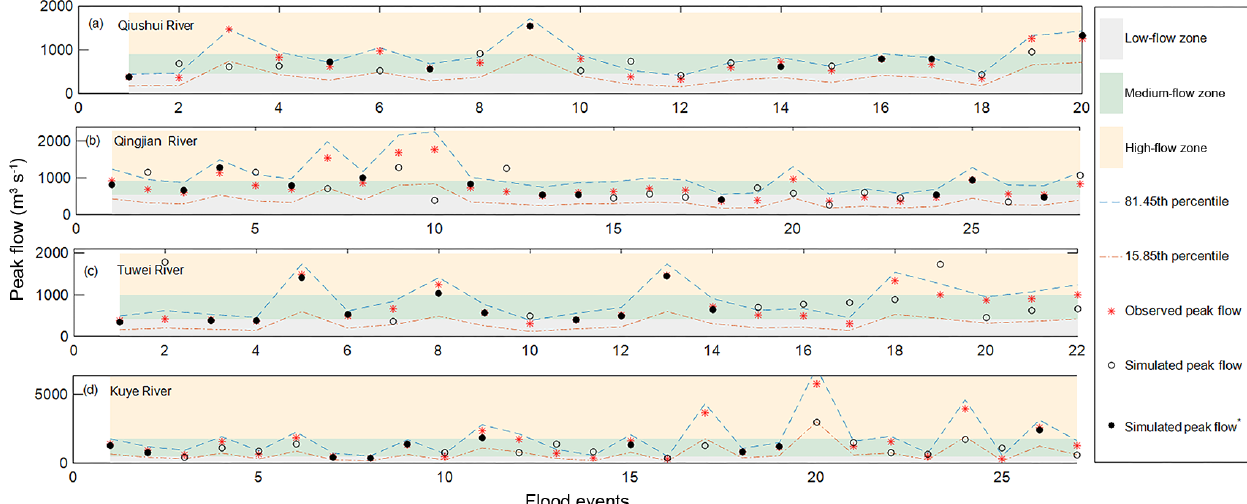
Figure 5. Observed peak flows (red asterisk) and simulated peak flows (circles) with the VMM for each catchment under conditions C1–C3. Flood peaks conforming to condition C1 are represented by solid circles and the others are empty; the three flow zones (low, medium and high flow zones) classified by condition C2 are shown in gray, green and off-white, respectively; the 68.3% uncertainty interval of peak flows estimated by condition C3 is shown between the blue dashed line (81.45th percentile) and the red dashed–dotted line (15.85th